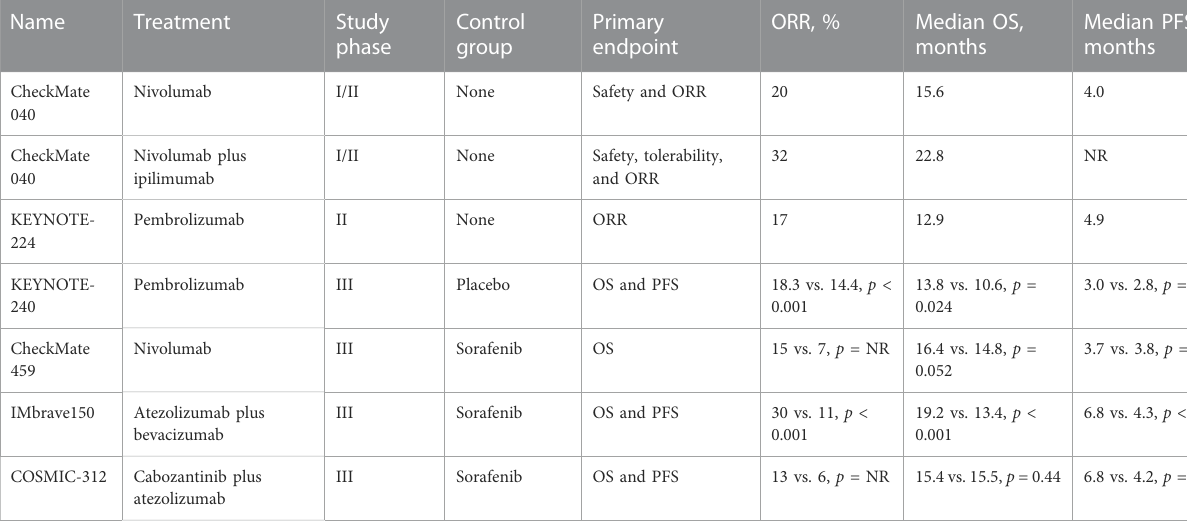
TABLE 1 Main randomized clinical trials of ICIs for advanced